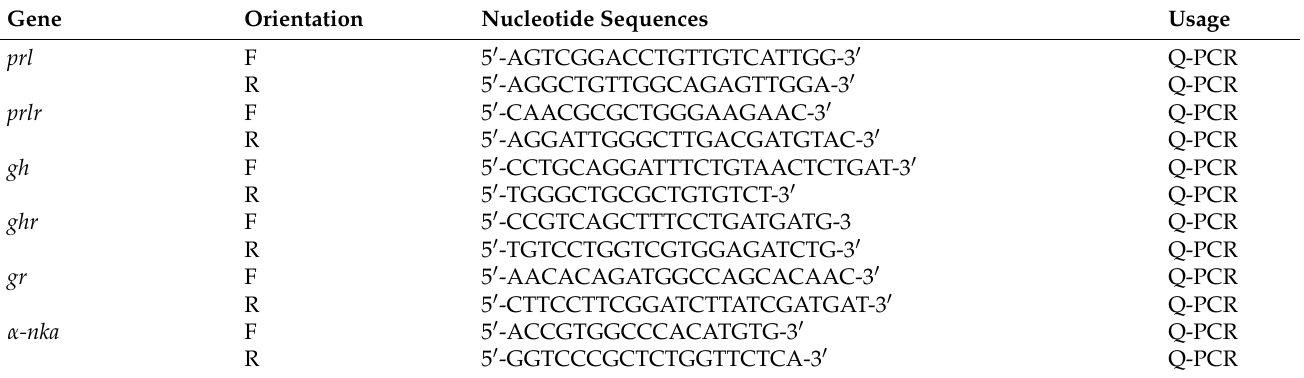
Table 1. Specific primers used for Q-PCR analysis. F: forward primer, R: reverse